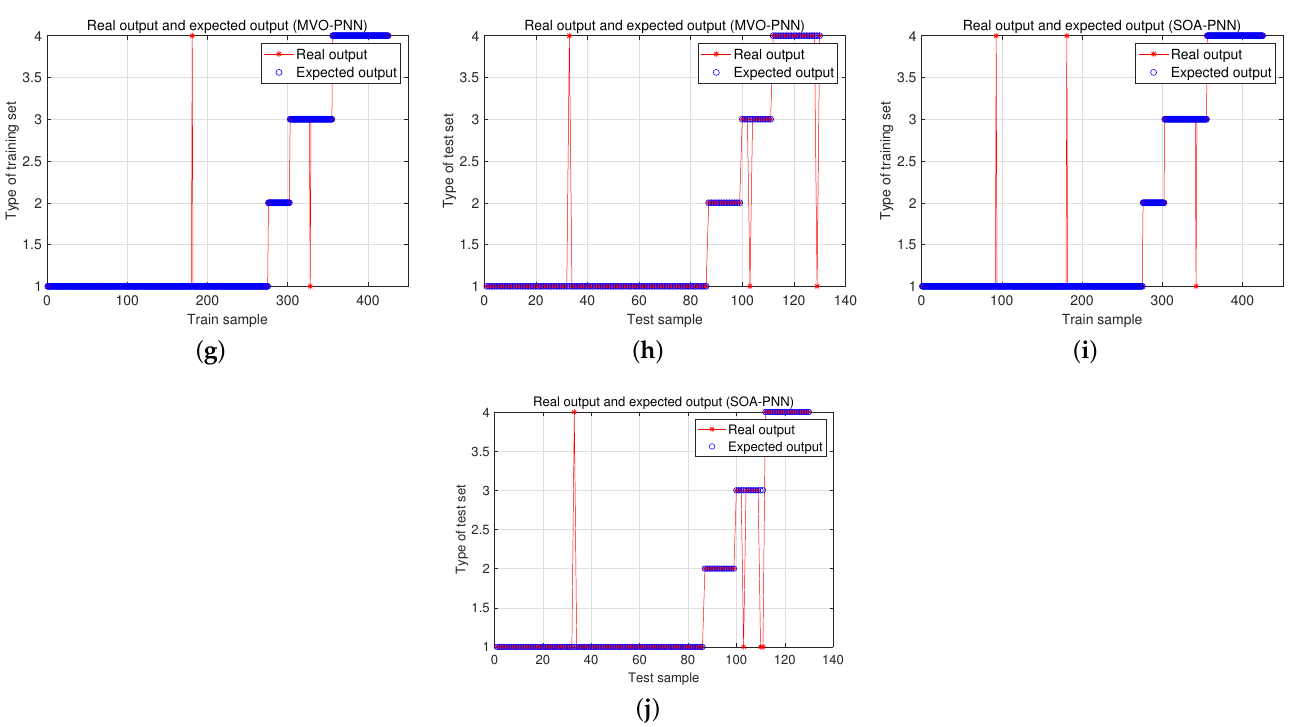
Figure 8. Comparison of the diagnosis results of the second set of comparative experiments. ( a , c , e , g , i ) represent the results of train sample classification for different methods, respectively. ( b , d , f , h , j ) are the results of testsample classification for different methods, respectively.